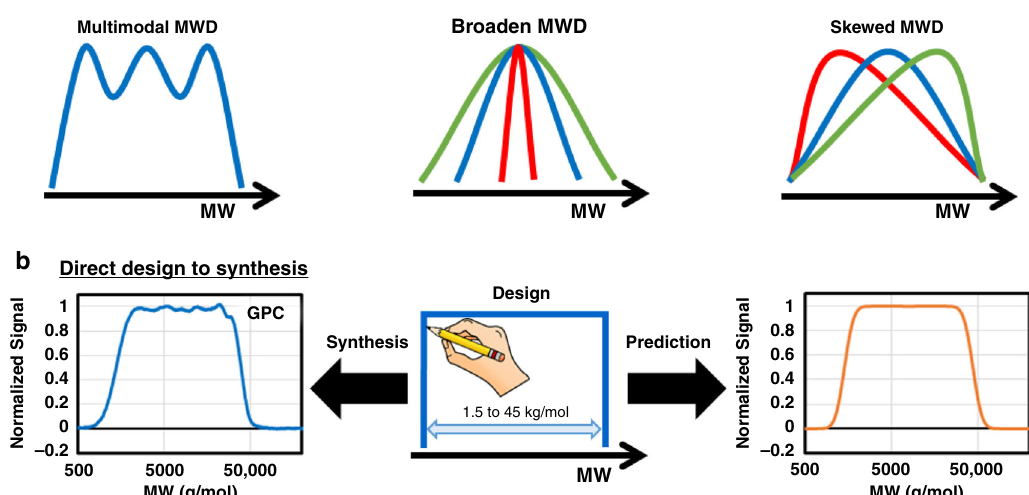
Fig. 1 Overview of prior literature and this manuscripts methodology. a Prior literature on MWD design. b Direct design to syntheisis methodology. MW molecular